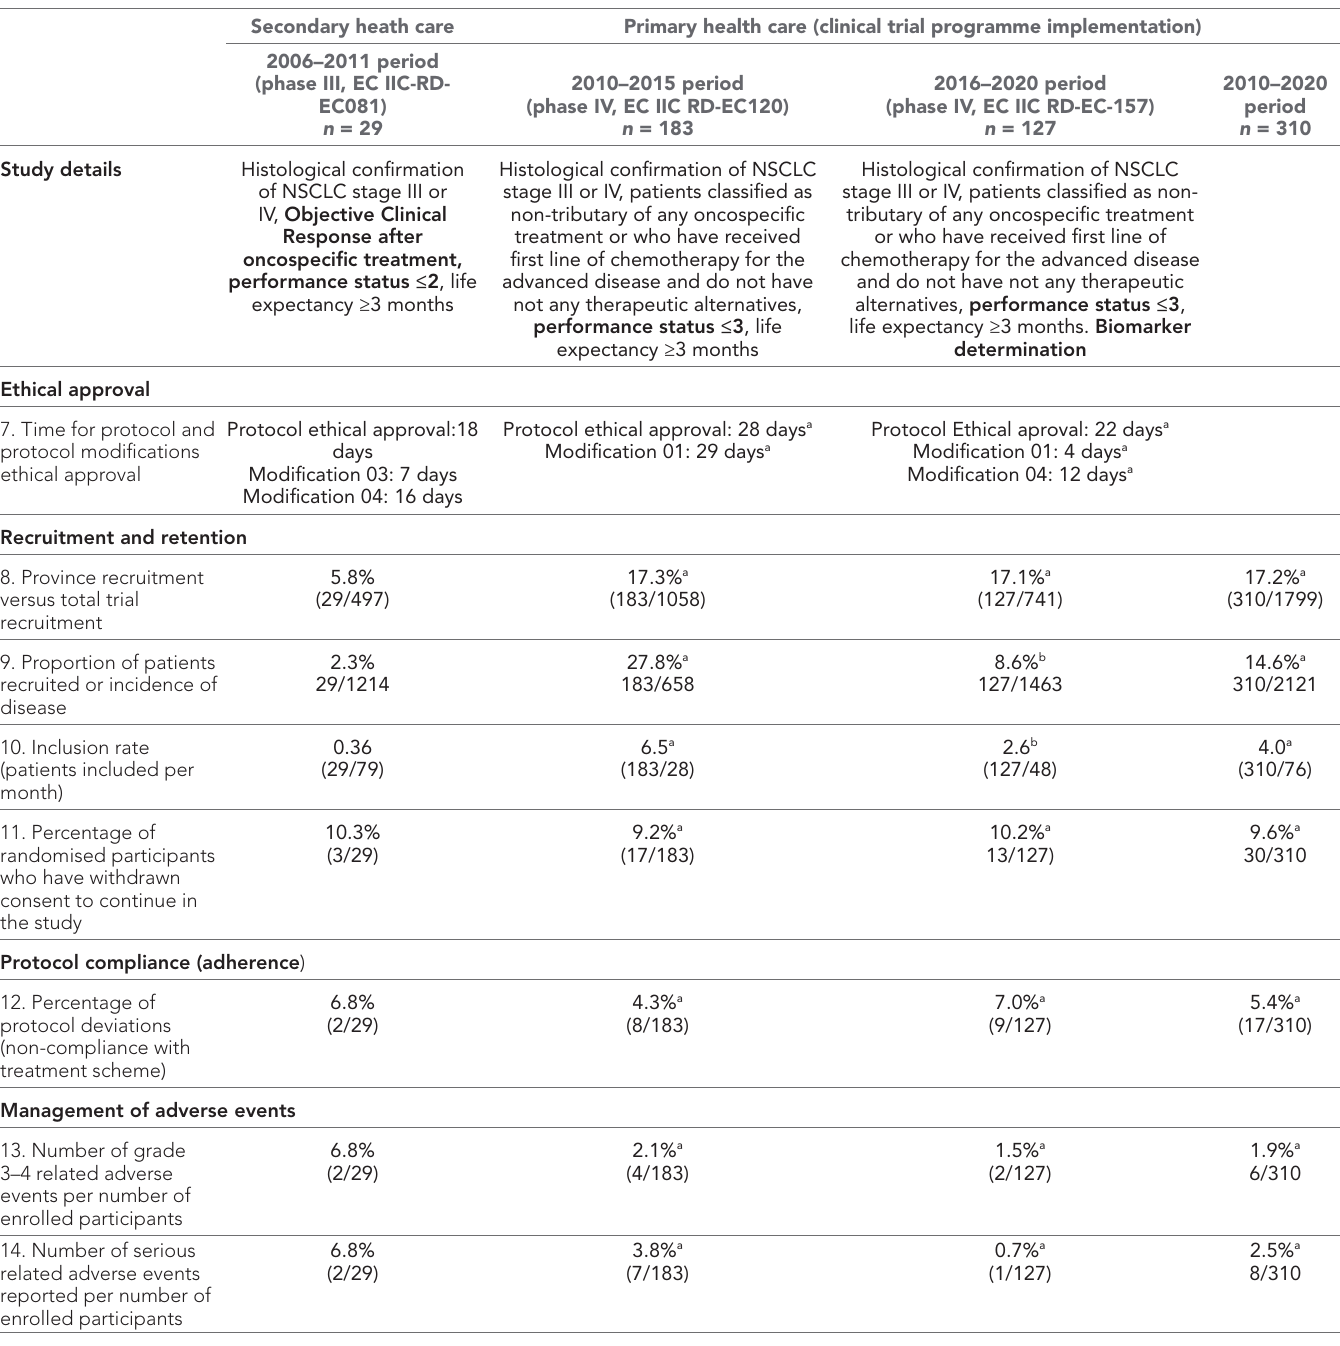
Table 2 Process indicators in multicentre oncology clinical trials conducted in primary health care in Villa Clara province.